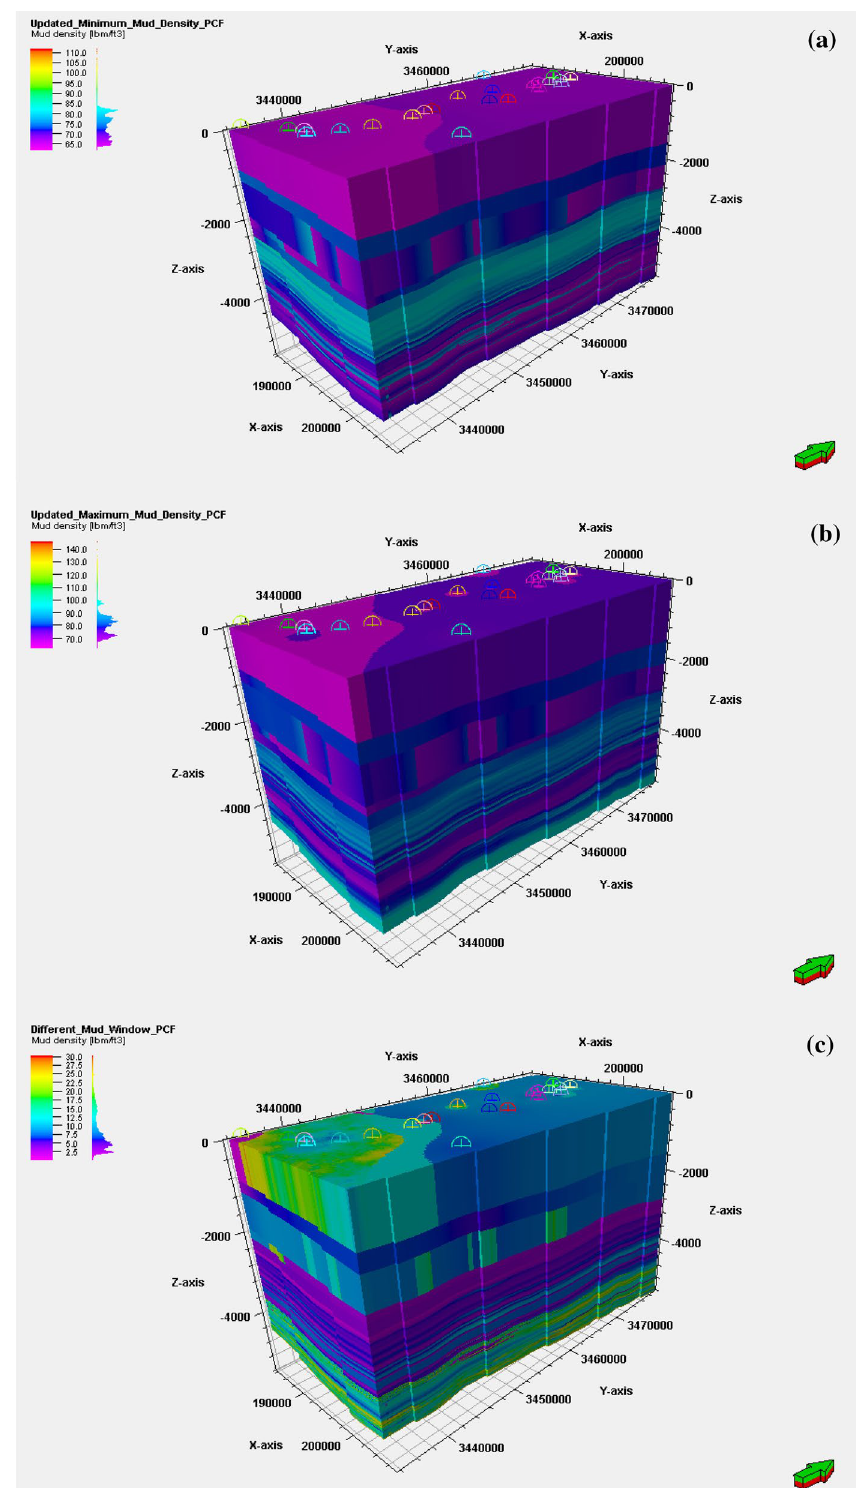
Fig. 12 Final cubes of a mini- mum MW (PCF), b maximum MW (PCF), c difference MW (between 2.5 and 30 PCF) in the South Azadegan